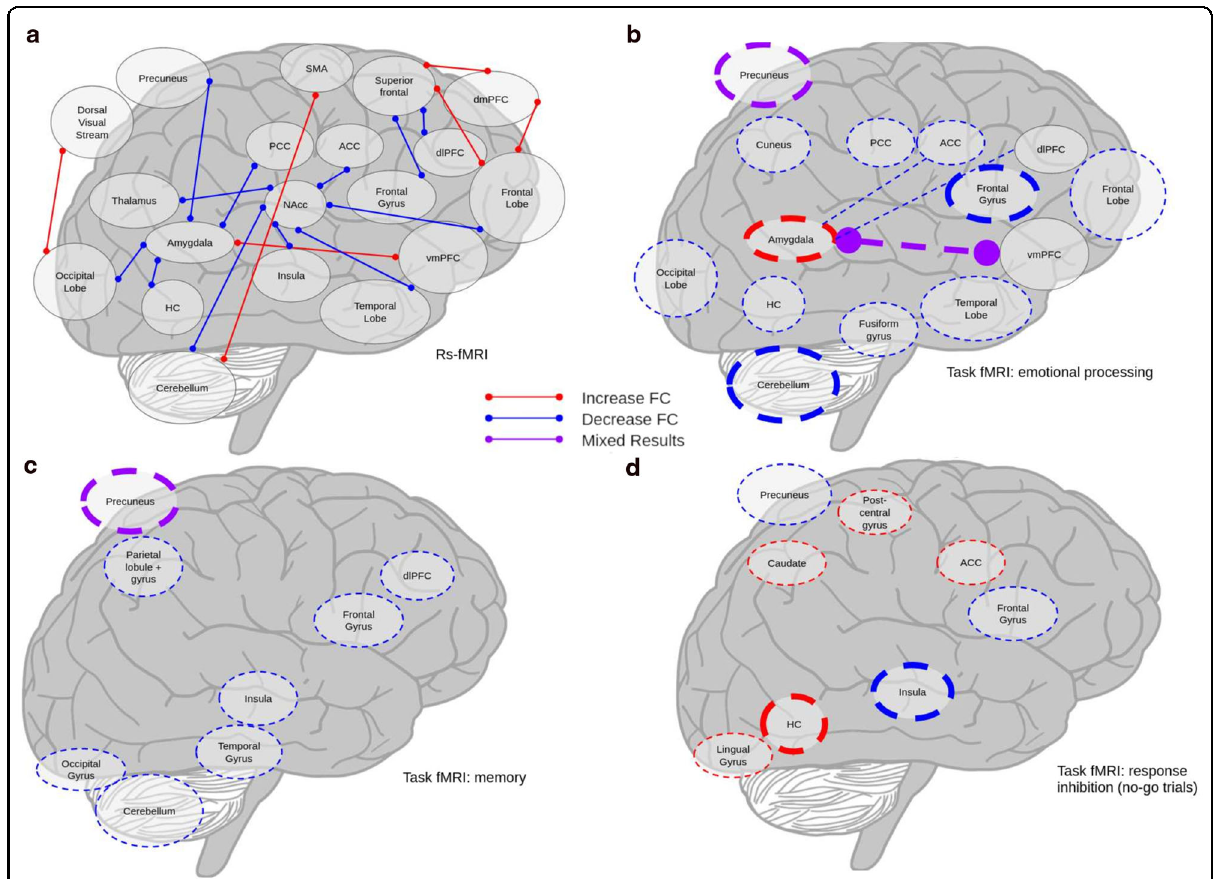
Fig. 2 Visualization of main fMRI results across studies. a rs fMRI results, b er fMRI results, emotional processing tasks, c er fMRI results, memory tasks, d er fMRI results, no-go trials from response inhibition. Thin lines indicate results from one study. Thick lines indicate results from two. Solid lines indicate rs fMRI, dashed indicate resting state. Colored circles demarcate “ activity ” lines indicate “ connectivity ”